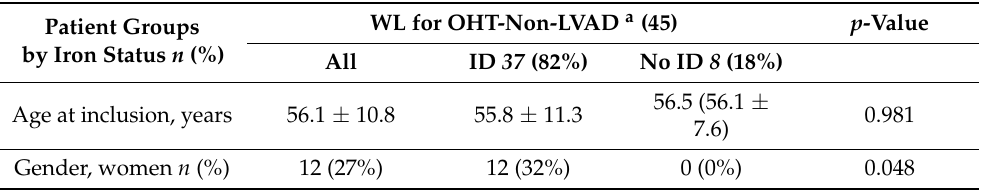
Table 2. Characteristics of patients without LVAD implanted according to iron status. WL—waiting list, OHT—orthotopic heart transplantation, LVAD—left ventricle assist device, LVEF—left ventricular ejection fraction; NT-proBNP—N-terminal pro-B-type natriuretic peptide; NYHA—New York Heart Association, HF—heart failure, CM—cardiomyopathy, Values are median (average ± standard deviation) unless otherwise